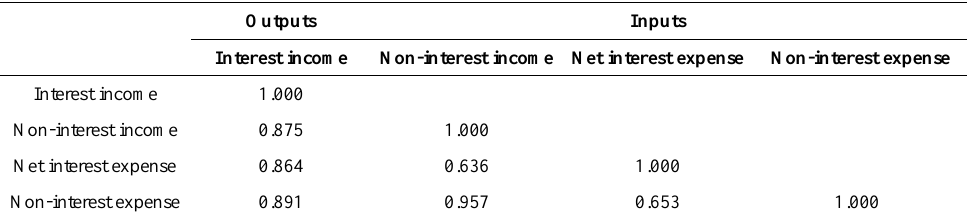
Table 1. Correlation coefficients between inputs and outputs